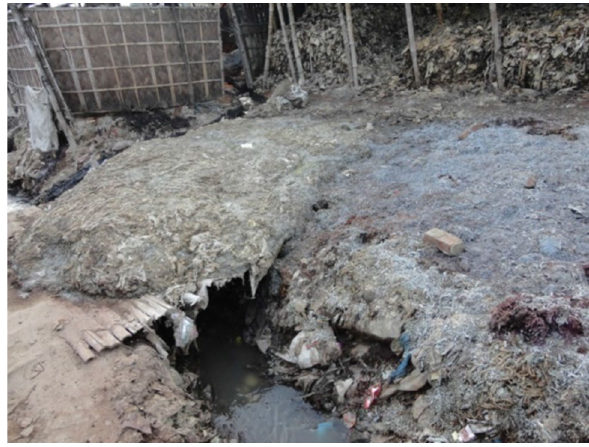
Fig. 4 Tannery effluent mixes with sewer